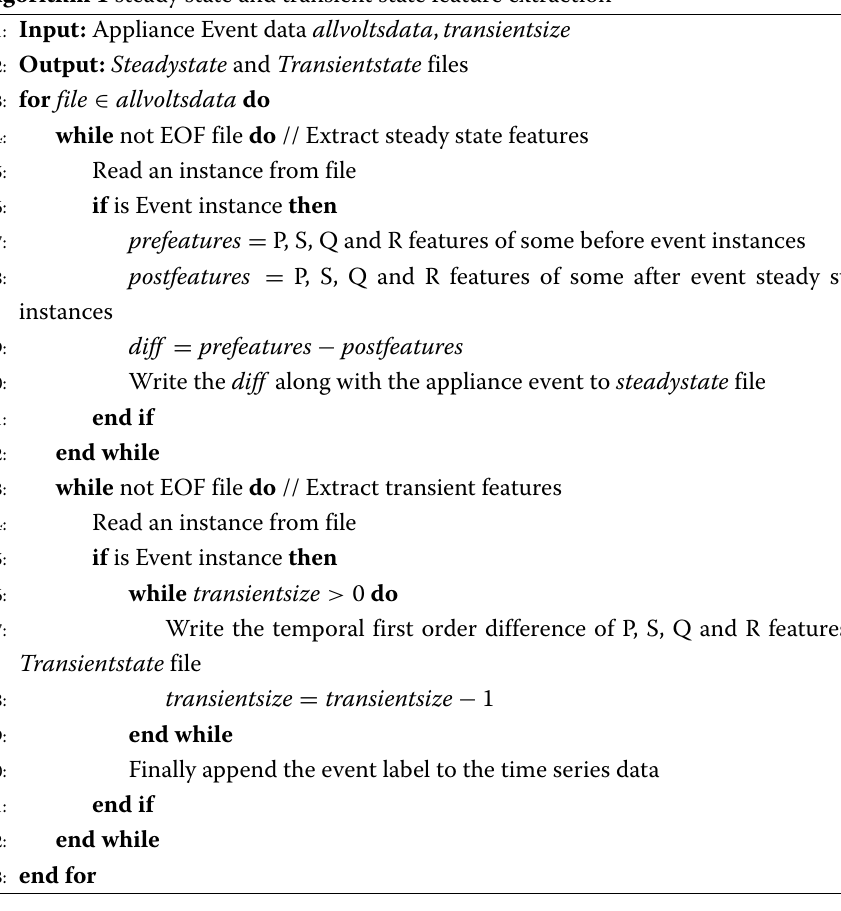
Algorithm 1 steady state and transient state feature extraction